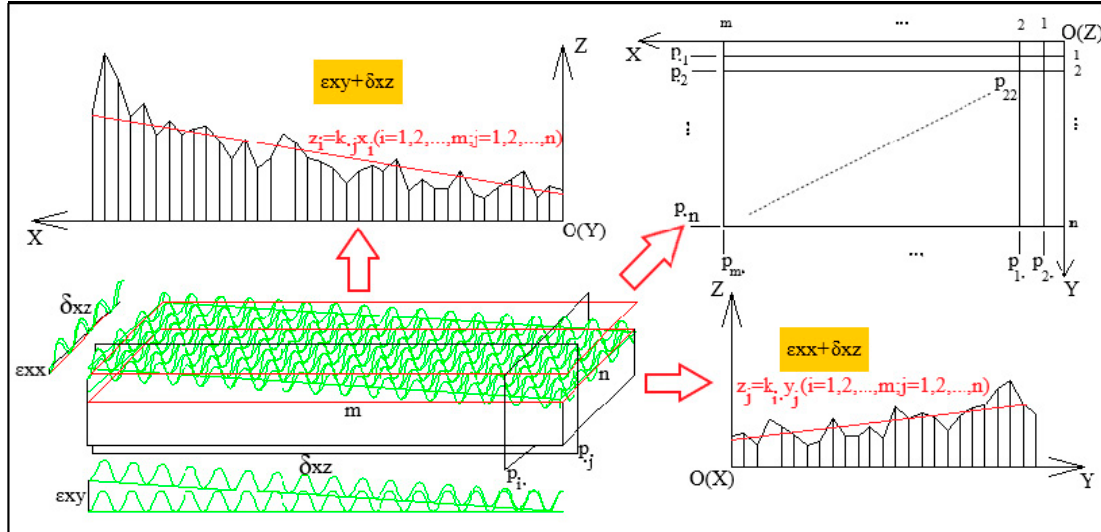
Figure 6. Geometric error decoupling of the X-axis.